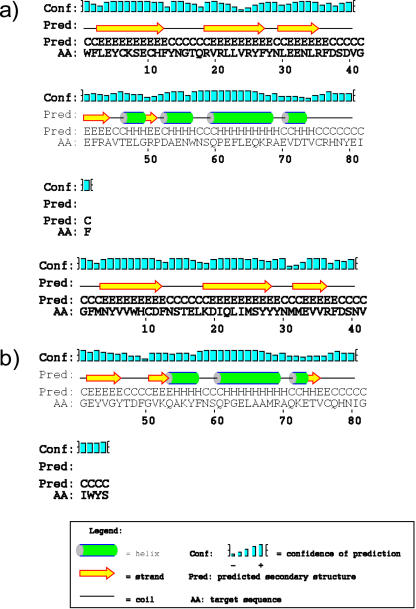
Comparison of Secondary Structure of Mouse and Cichlid MHC Class II Exon 2.Structure predictions were obtained from the PSIPRED server (http://bioinf.cs.ucl.ac.uk/psipred/psiform.html) for a) mouse sequence gi:13399459 and b) cichlid sequence Psemmil_m58_c (Accession number: EF540049). Mammalian and fish secondary structures are similar except for an additional short alpha-helix at position 46–49 predicted for the mouse sequence, and an additional short strand at position 74 predicted for the cichlid sequence.